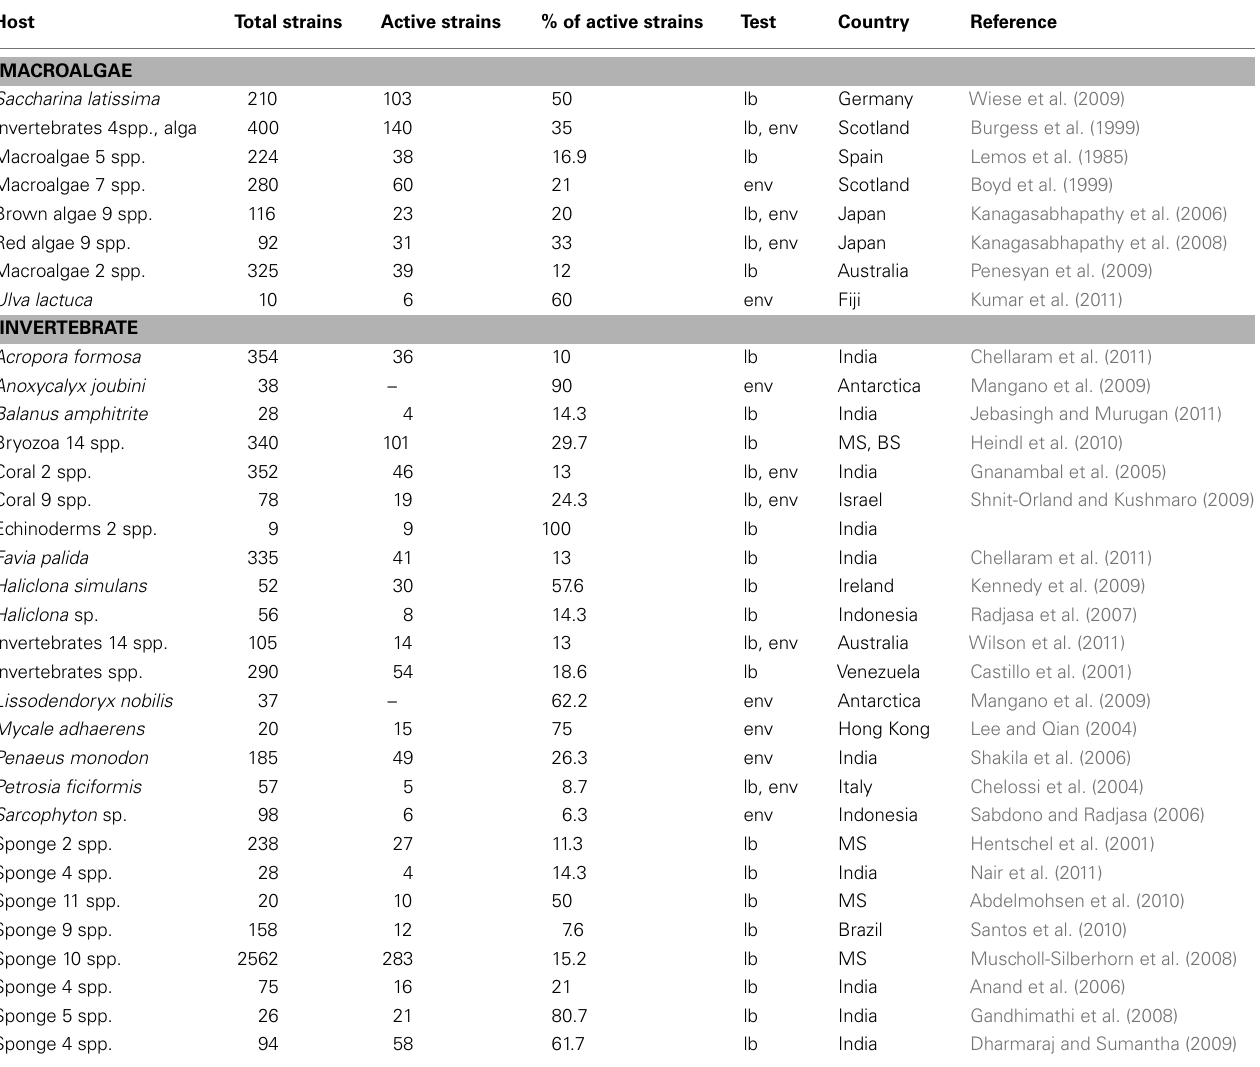
Table 2 |Antimicrobial activity of epibiotic bacterial strains isolated from different